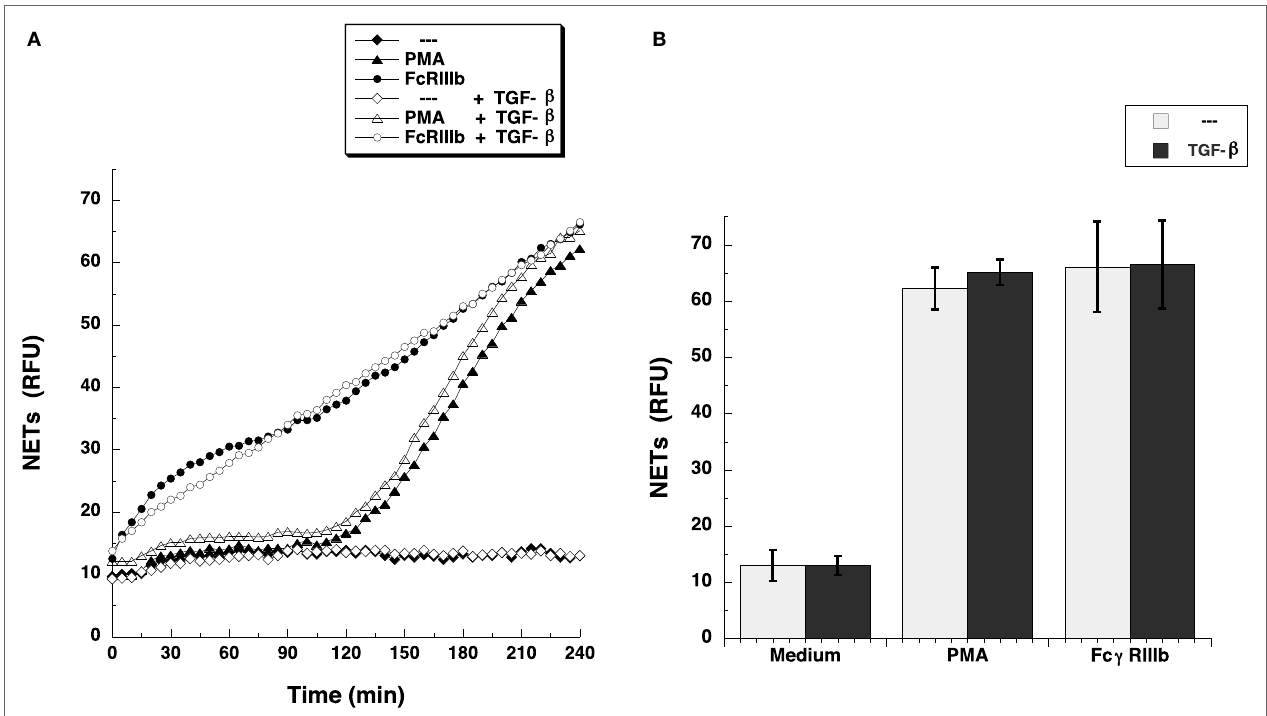
FigUre 3 | TgF- β does not affect Fc γ riiib-induced neT formation . (a) human neutrophils were left untreated (---), or were stimulated with 20 nM phorbol 12-myristate 13-acetate (PMA), or by cross-linking Fc γ RIIIb, and then incubated for 4 h. Some neutrophils were previously treated with 5 ng/ml transforming growth factor- β (TGF- β ) (white symbols) or with only the solvent (DMSO) (black symbols). The relative amount of NETs was estimated from SYTOX ® Green fluorescence in relative fluorescent units (RFU) every 5 min. Data are mean ± SEM of three experiments done in tetraplicates. (B) human neutrophils were previously treated with solvent alone (---) or with 5 ng/ml TGF- β , before stimulating with nothing (Medium), 20 nM PMA, or by cross-linking Fc γ RIIIb, and then incubated for 4 h. The relative amount of NETs was estimated from SYTOX ® Green fluorescence in relative fluorescent units (RFU) at 4 h after stimulation. Data are mean ± SEM of three experiments done in